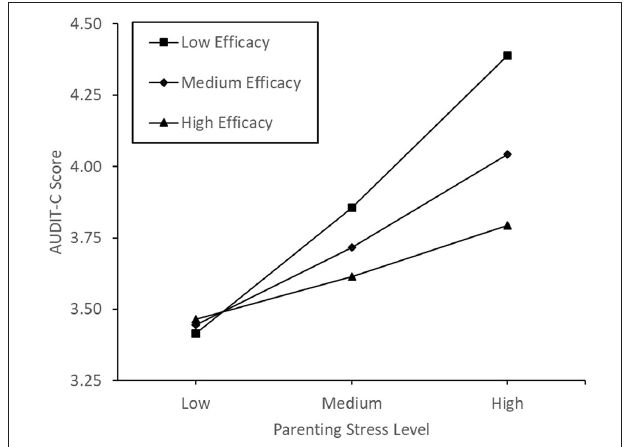
FIGURE 4 | Conditional effects of parenting self-efficacy on the correlation between parenting stress and alcohol consumption.